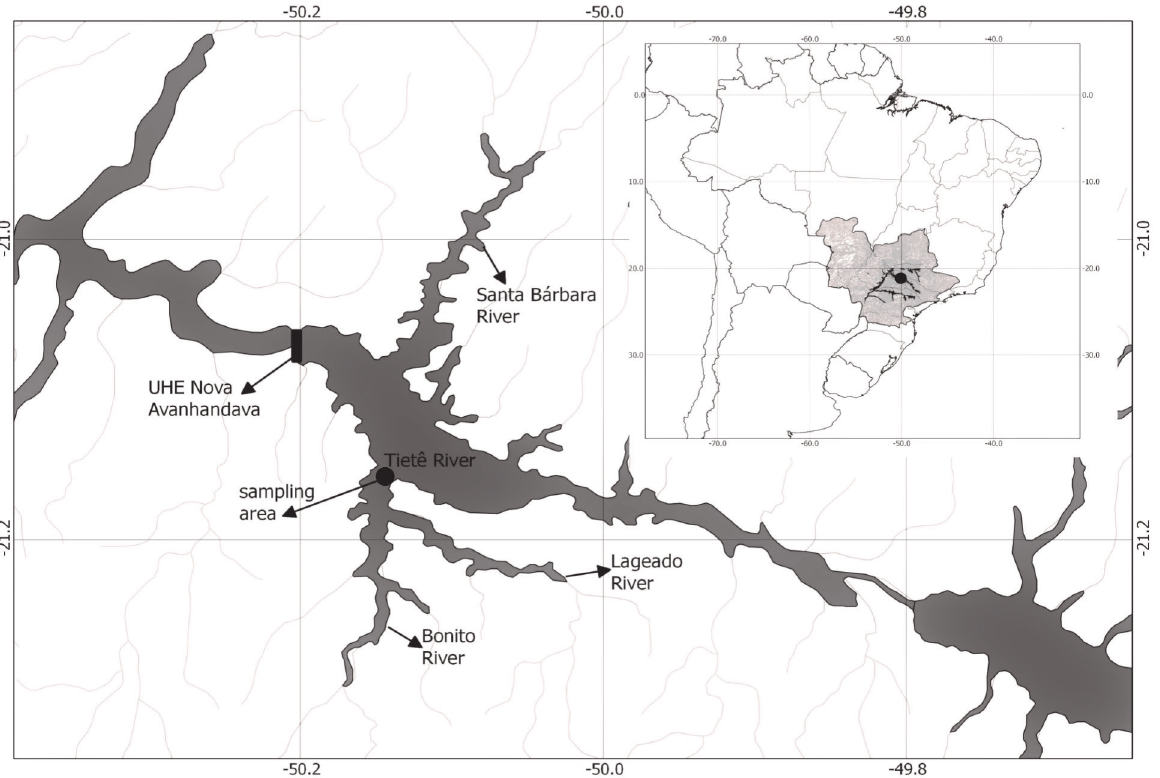
Figure 1. Nova Avanhandava reservoir (Lower Tietê Basin) indicating the sampling area in the Bonito River, State of São Paulo,